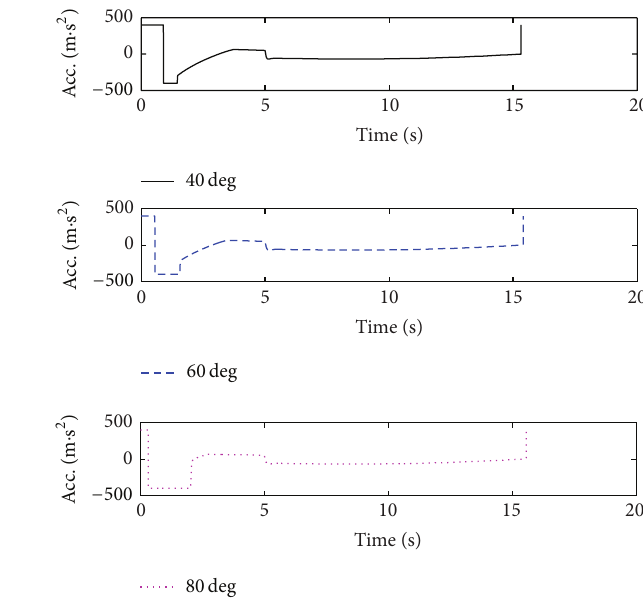
Figure 34: LOS angle.